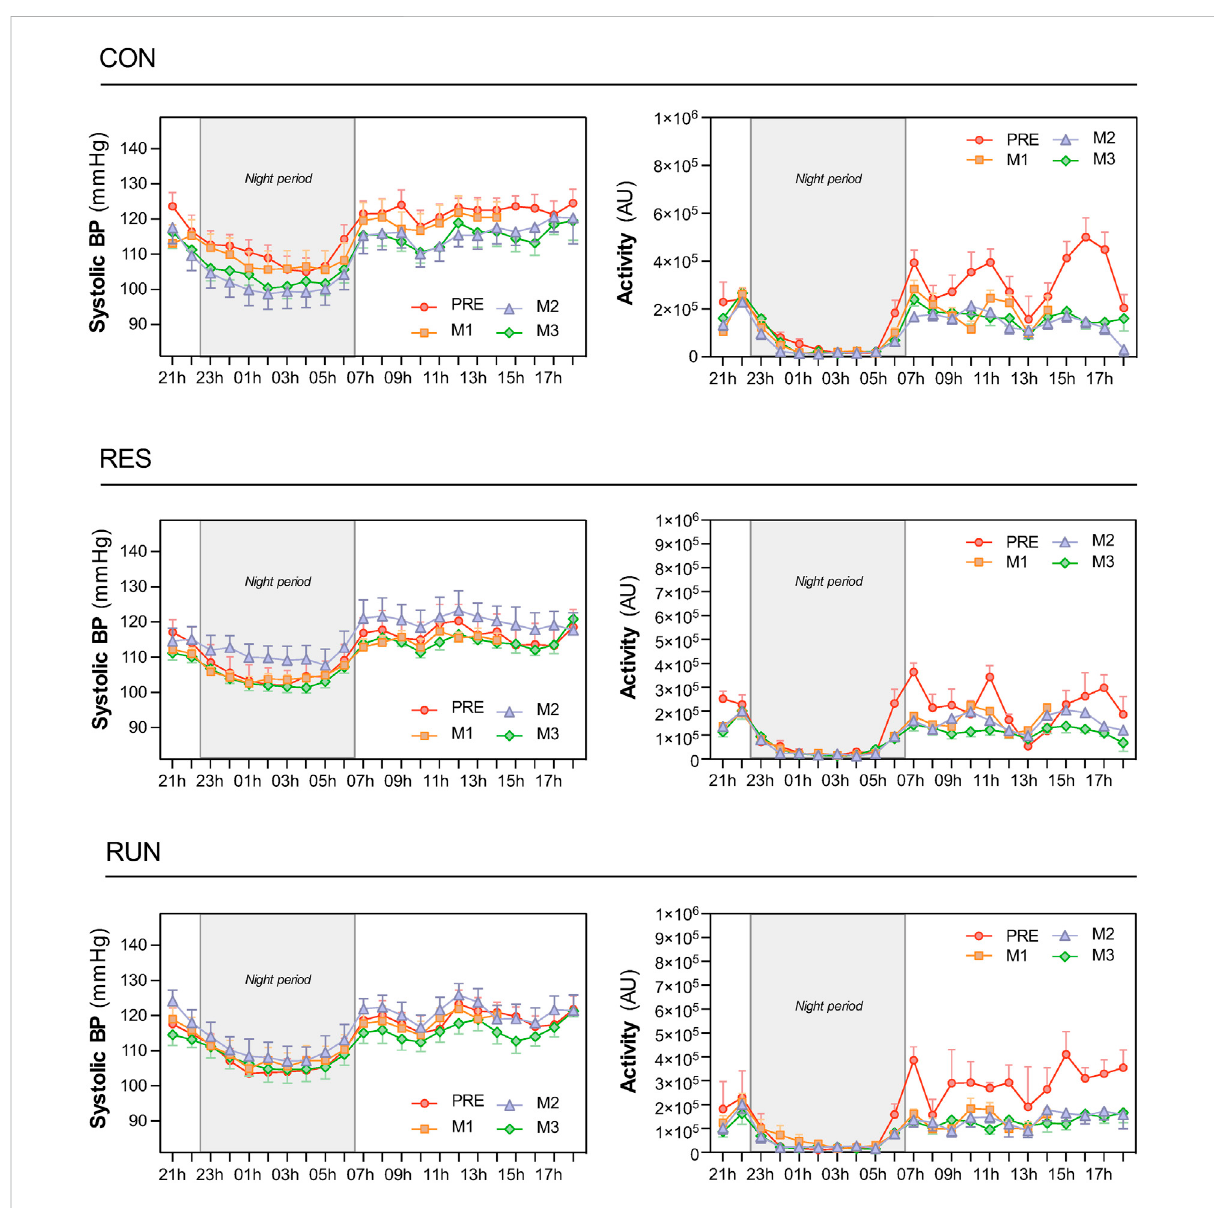
FIGURE 6 Circadian patterns of systolic blood pressure and physical activity. Recordings were performed using the SOMNOtouch ™ device over 21 h, before HDBR and at the end of each month (M1, M2, and M3). The night period was 22:30 – 06:30. The sample size was n = 8/CON, n = 7/RES, n = 7/ RUN. Data are presented as the mean ±